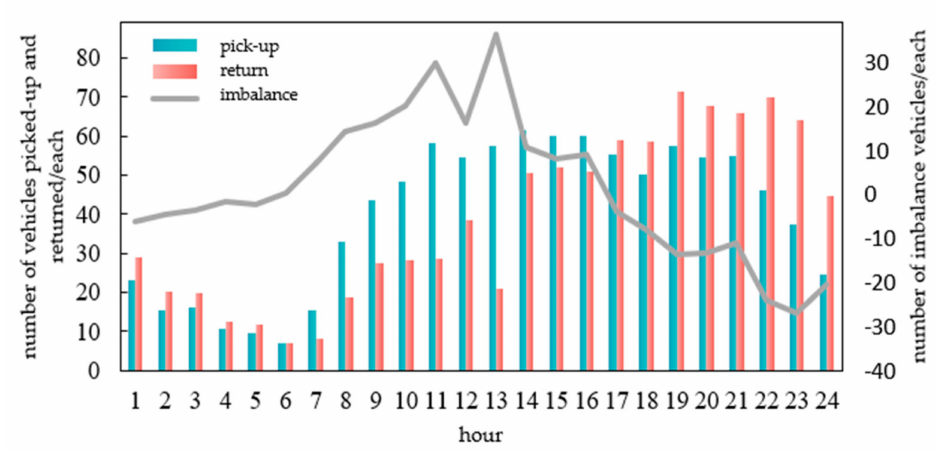
Figure 4. Number of vehicles picked up and returned in different periods on weekends.